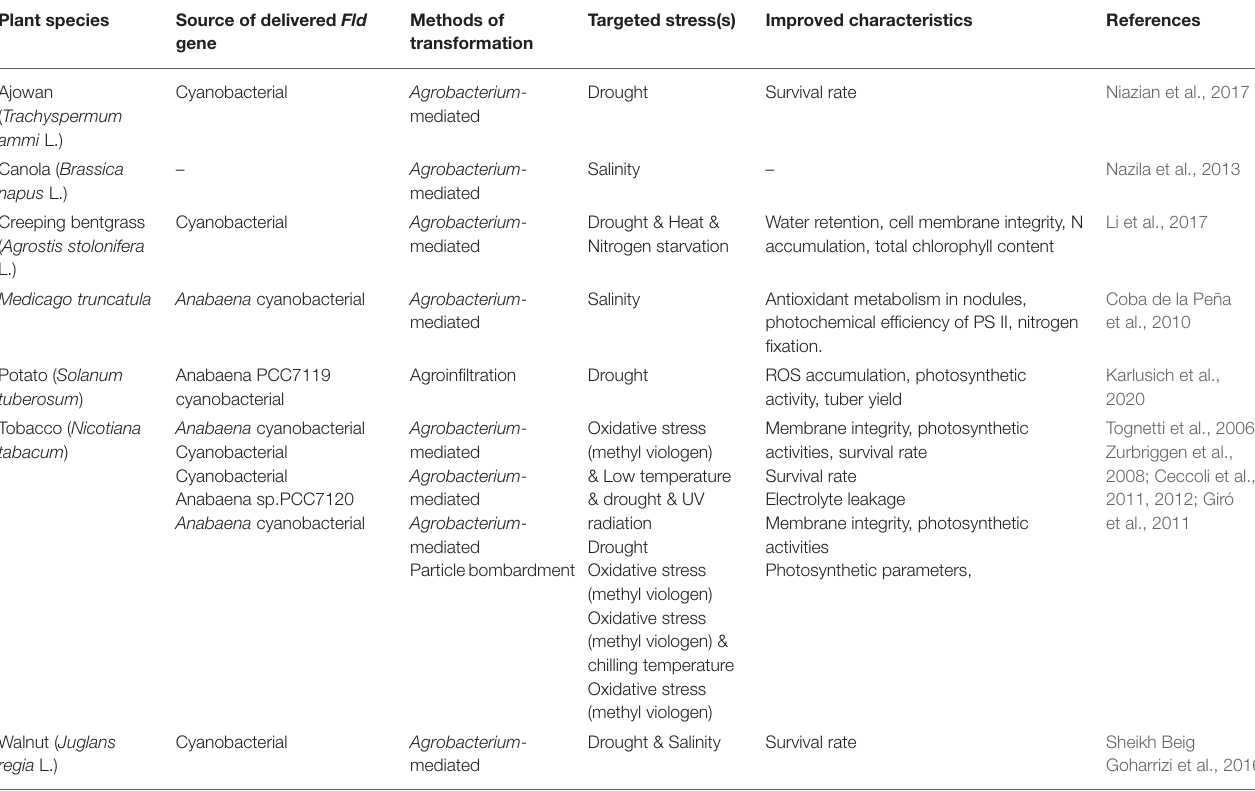
TABLE 2 | Heterologous expression of Fld gene to enhance abiotic stresses in different plant species. Plant species